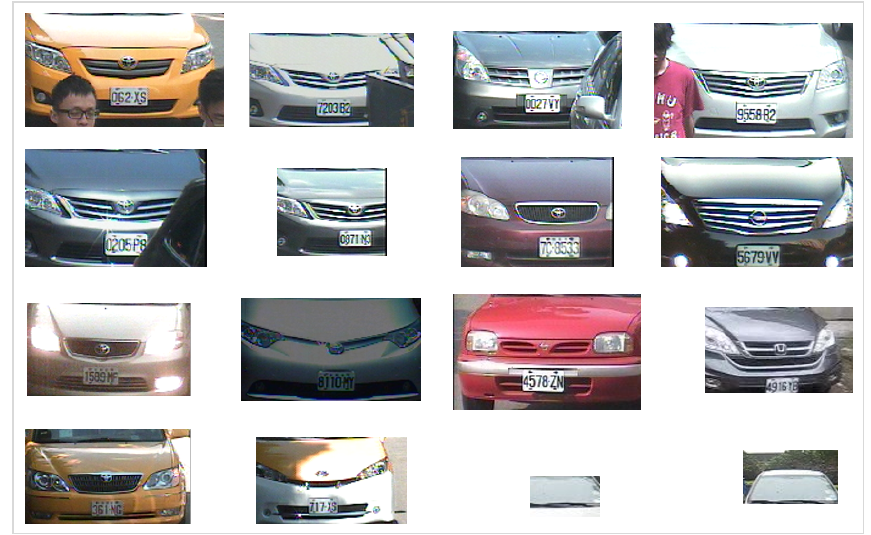
Figure 8. Some of the challenging scenarios in the NTOU-MMR dataset. The BoE-based approaches were successful in predicting the make–model class in all of the above cases except the last two (noisy